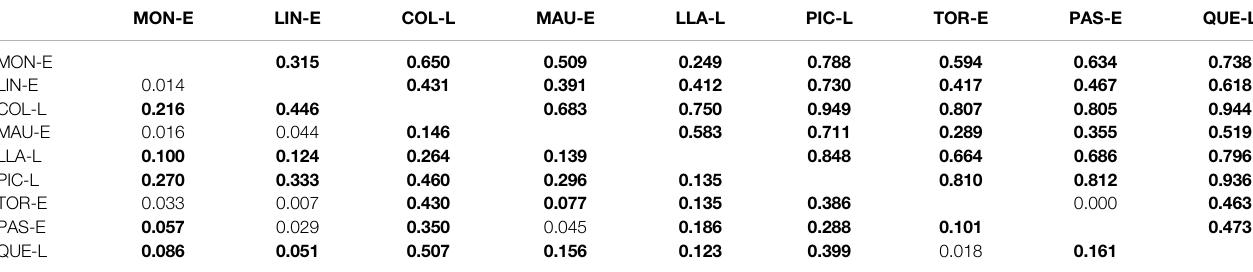
TABLE 3 | Matrix of genetic differentiation values between pairs of Galaxias maculatus locations, estimated by mean general pairwise values of differentiation (N ST ) of Mitochondrial DNA data (above diagonal) and estimated by F ST obtained from the nine microsatellite loci (below diagonal). MON-E